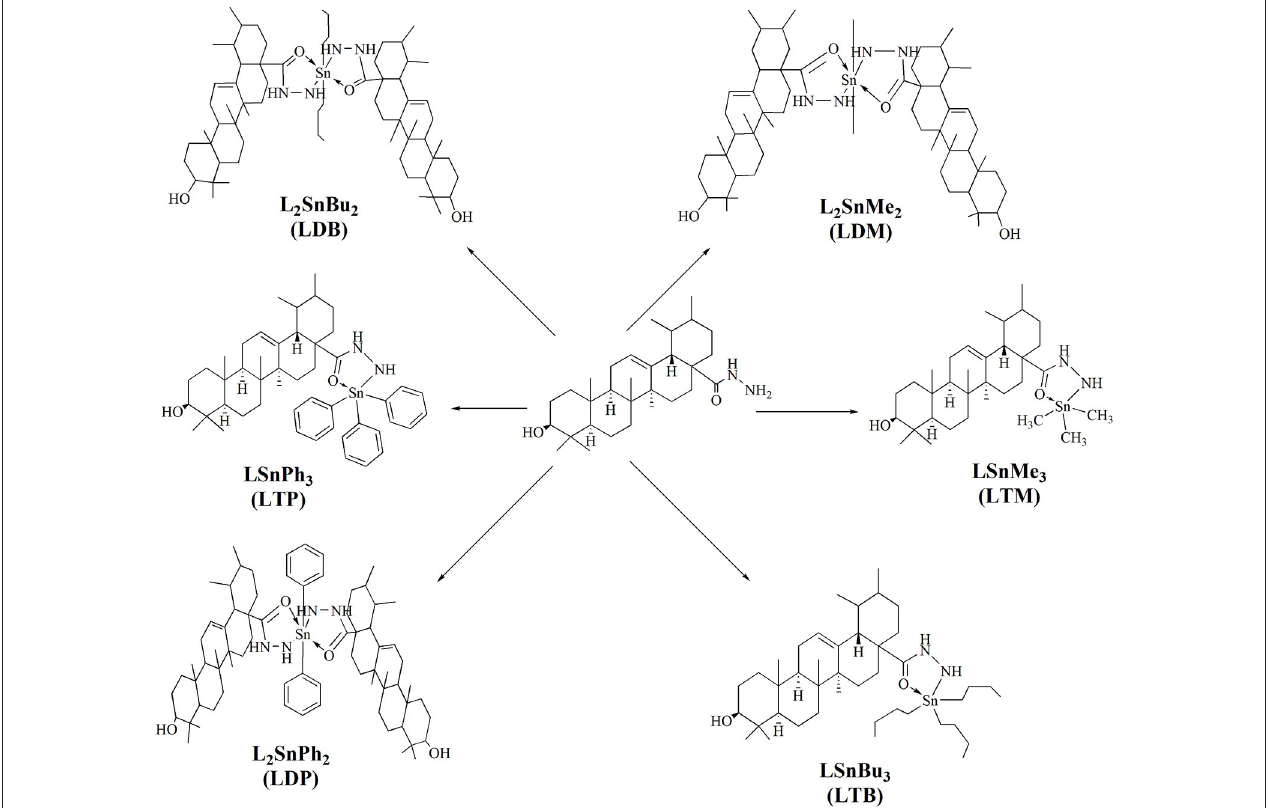
FIGURE 3 | Synthesis of tin